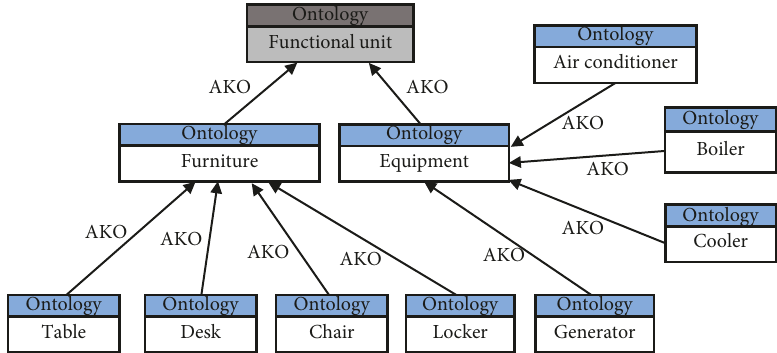
Figure 5: Functional units (FUs).